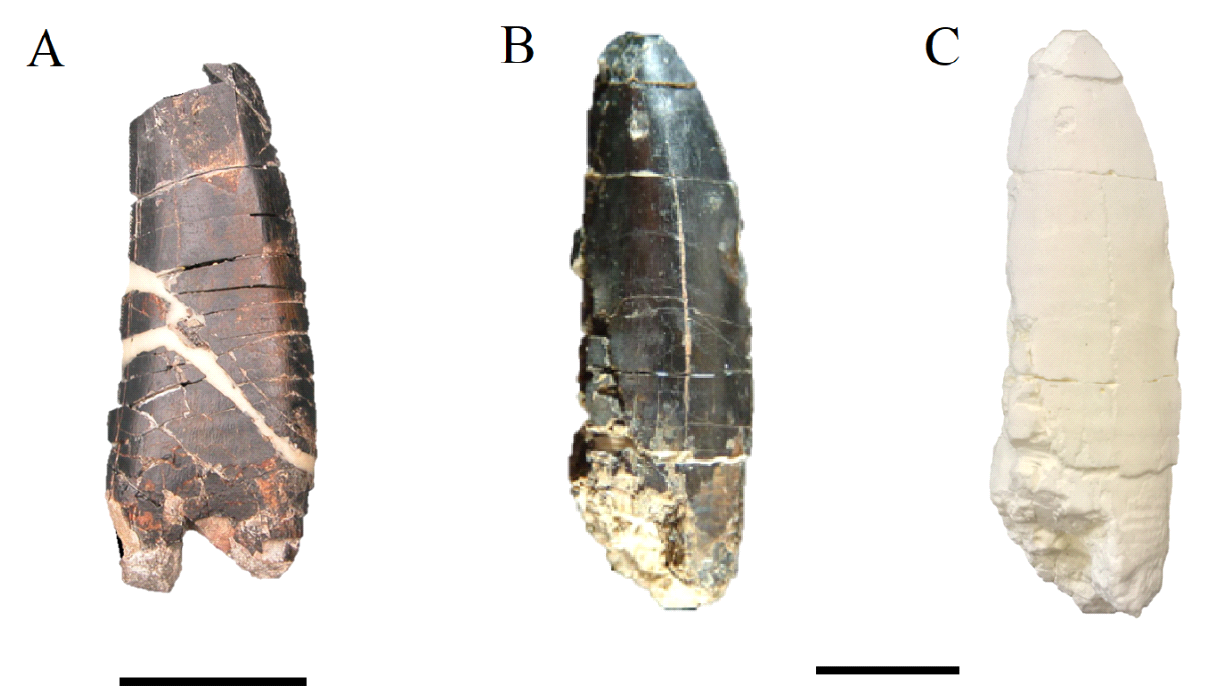
Fig. 3. Large theropod teeth that recovered from the Hasandong Formation. cf. Acrocanthosaurus sp. KIGAM VP 200501 (A), Carcharodontosauridae indet. KS 7001 (B), and cast of KS 7001 (C). A and B are modified from Lee (2007) and Yun et al. (2007). Scale bar = 30 mm (A), =20 mm